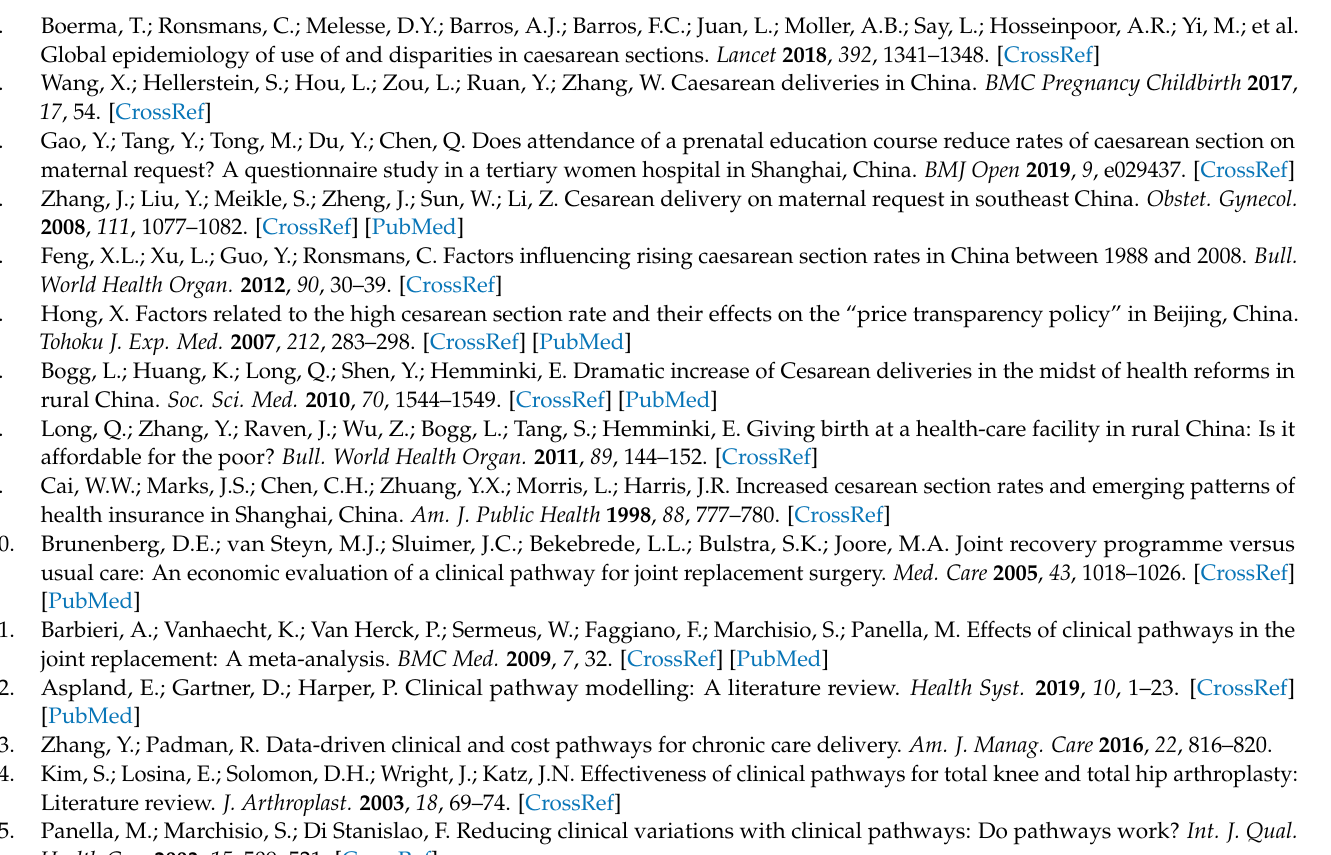
using the Cochrane risk of bias tool, Figure S2: Risk of bias presented as percentages across all included studies, Figure S3: Galbraith plot of effects on LOS, Figure S4: Galbraith plot of effects on DHC, Figure S5: Sensitivity analyses for assessing the impact of individual studies on the pooled estimate of LOS, Figure S6: Sensitivity analyses for assessing the impact of individual studies on the pooled estimate of DHC, Figure S7: Metafunnel funnel plot for the effect of LOS, Figure S8: Confunnel funnel plot of the effect on LOS, Figure S9: Egger’s linear regression of effect on LOS, Figure S10: Metafunnel funnel plot for effect of DHC, Figure S11: Confunnel funnel plot of effect on DHC, Figure S12: Egger’s linear regression of effect on